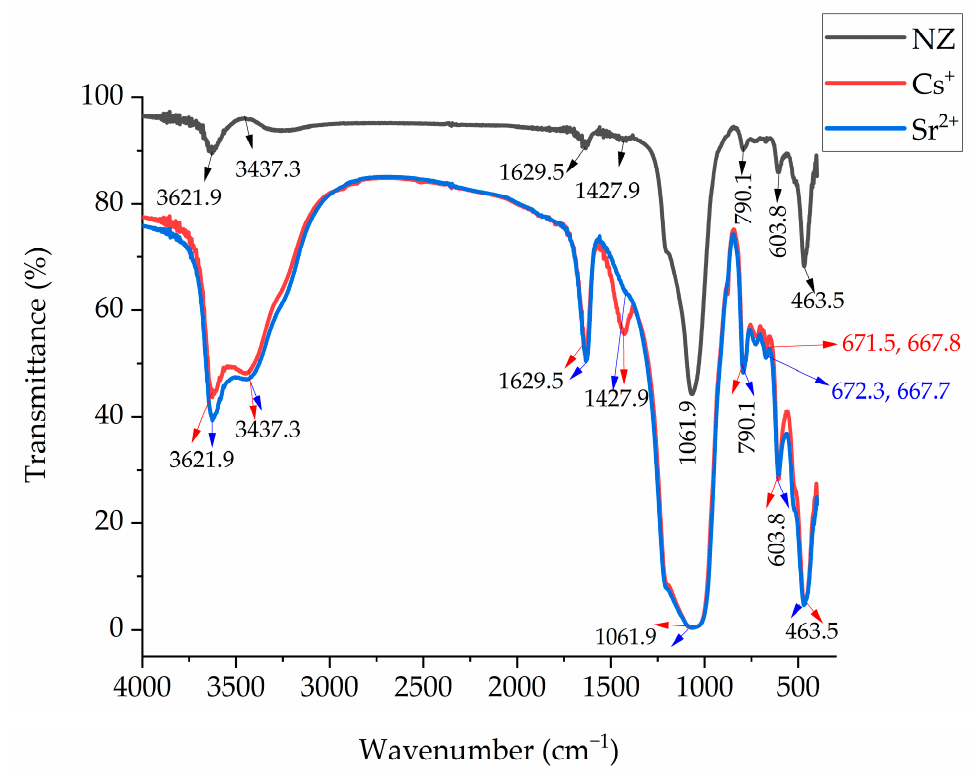
Figure 5. FTIR spectra of the zeolitic tuff sample before and after Cs + and Sr 2+ sorption.